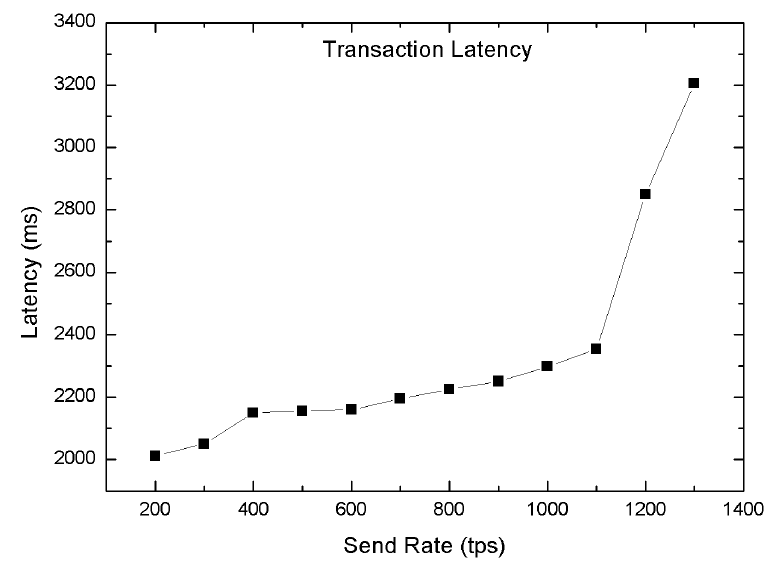
Figure 14. Average transaction